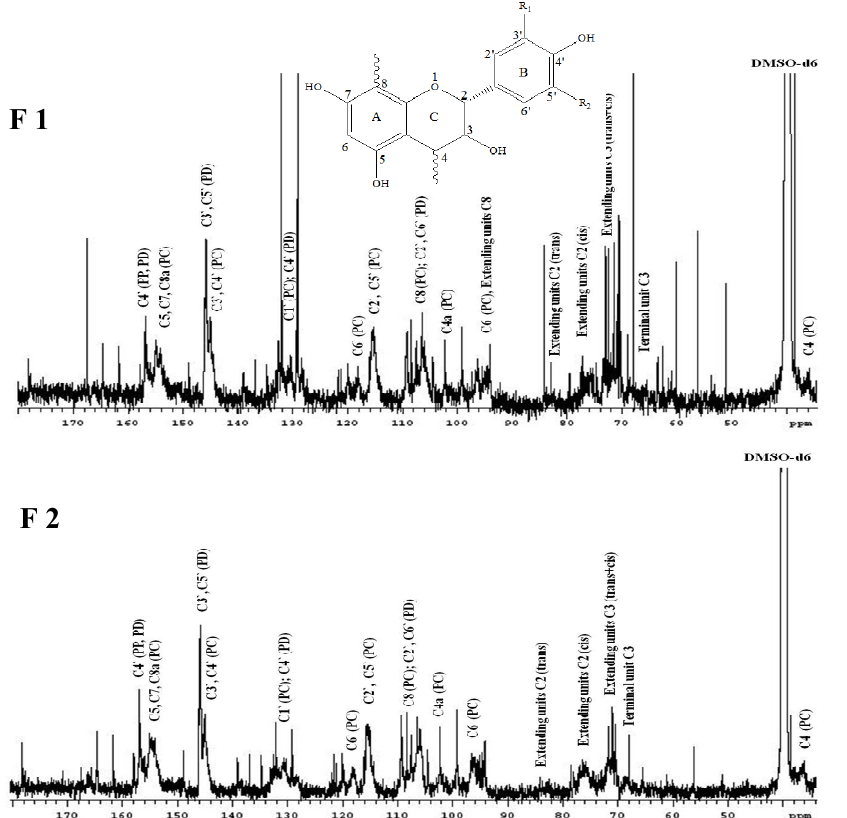
=R =OH, prodelphinidin 1 2